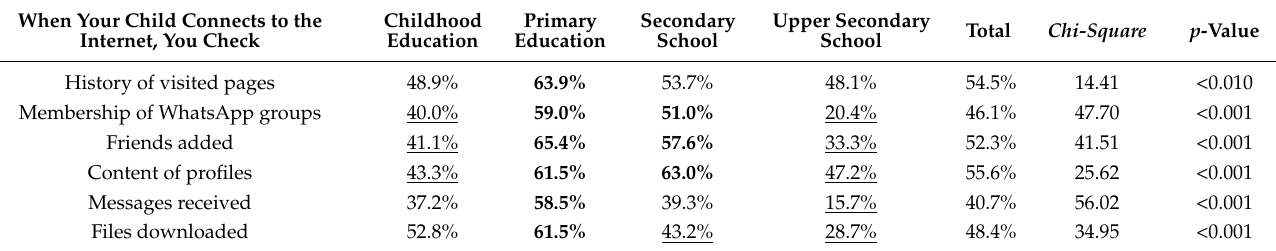
Table 4. Posterior parental control by educational